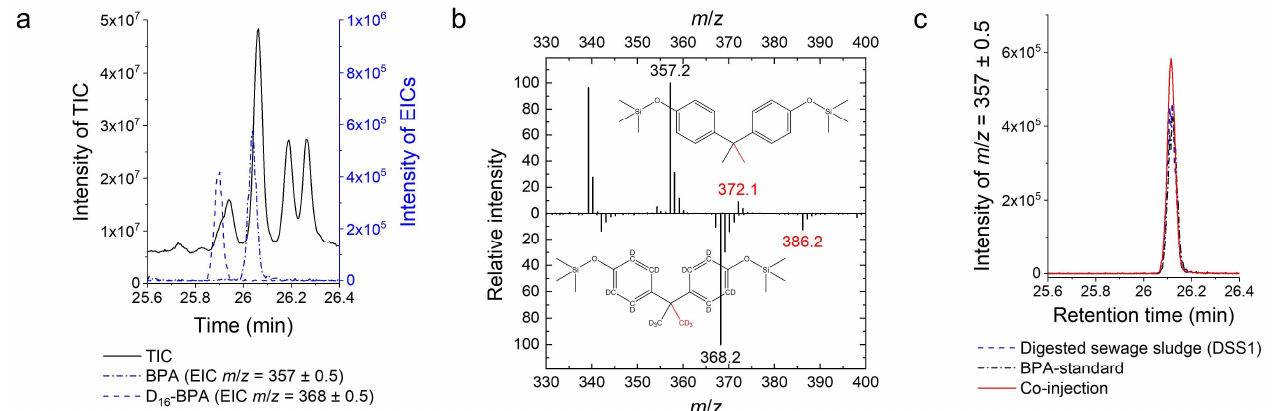
Figure 2. Analytical methodology, method development, and method evaluation: Bisphenol A measurements in the complex matrix: ( a ) Total ion chromatogram (TIC) and extracted ion chromatograms (EICs) of the most abundant fragments of analyte (BPA) and standard (D 16 -BPA) used for quantification. ( b ) Mass spectra of the analyte (BPA) and the internal standard (D 16 -BPA) in the complex matrix. The mass spectra ( m / z 330–400) at retention time 26.02–26.06 min (BPA) and 25.88–25.92 min (D 16 -BPA) show isotopic distributions of the molecular ions (red; m / z = 372, 386) and the most abundant fragments ( m / z = 357, 368) of TMS-BPA and TMS-D 16 -BPA, respectively. Structures of the molecular ions of the TMS derivatives are depicted, and fragment loss is highlighted. A matrix peak can be seen at m/z 339 in the BPA spectrum. ( c ) The presence of BPA was confirmed by co-injection of the sample and the BPA standard solution with a similar concentration.